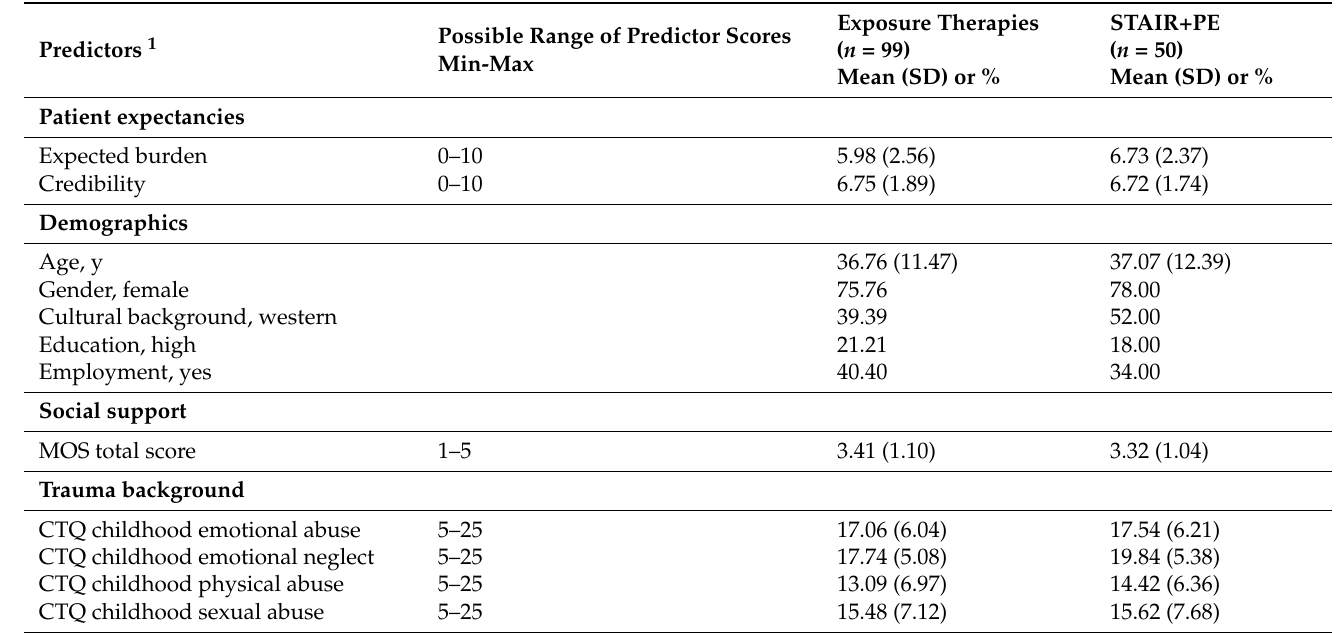
Table 1. Descriptive information about potential predictors for exposure therapies and